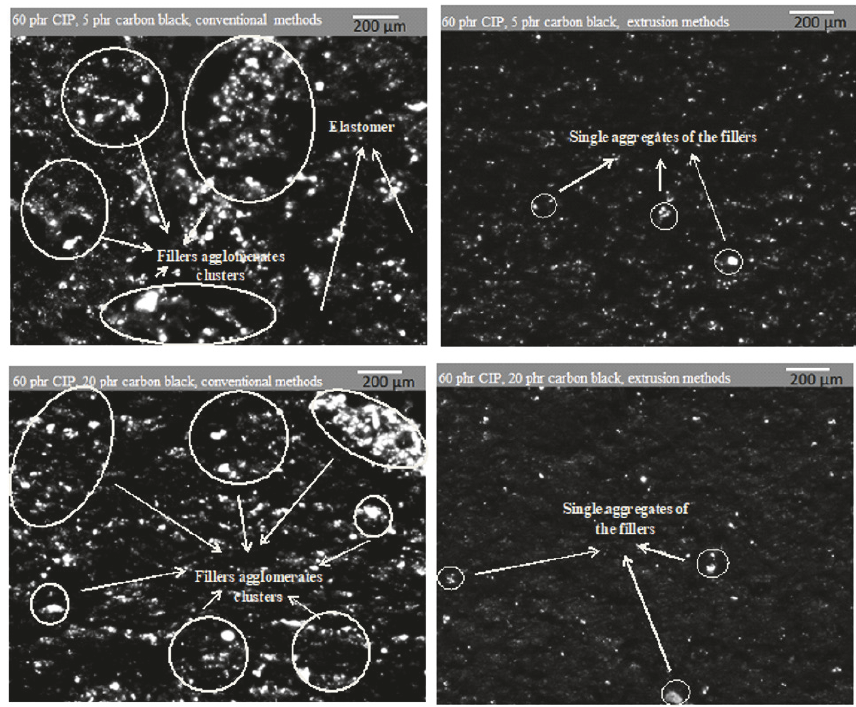
Figure 6: Morphological characteristics DisperTester images of composite filled with 60 phr CIP and 5 phr (up) and 20 phr (down) carbon